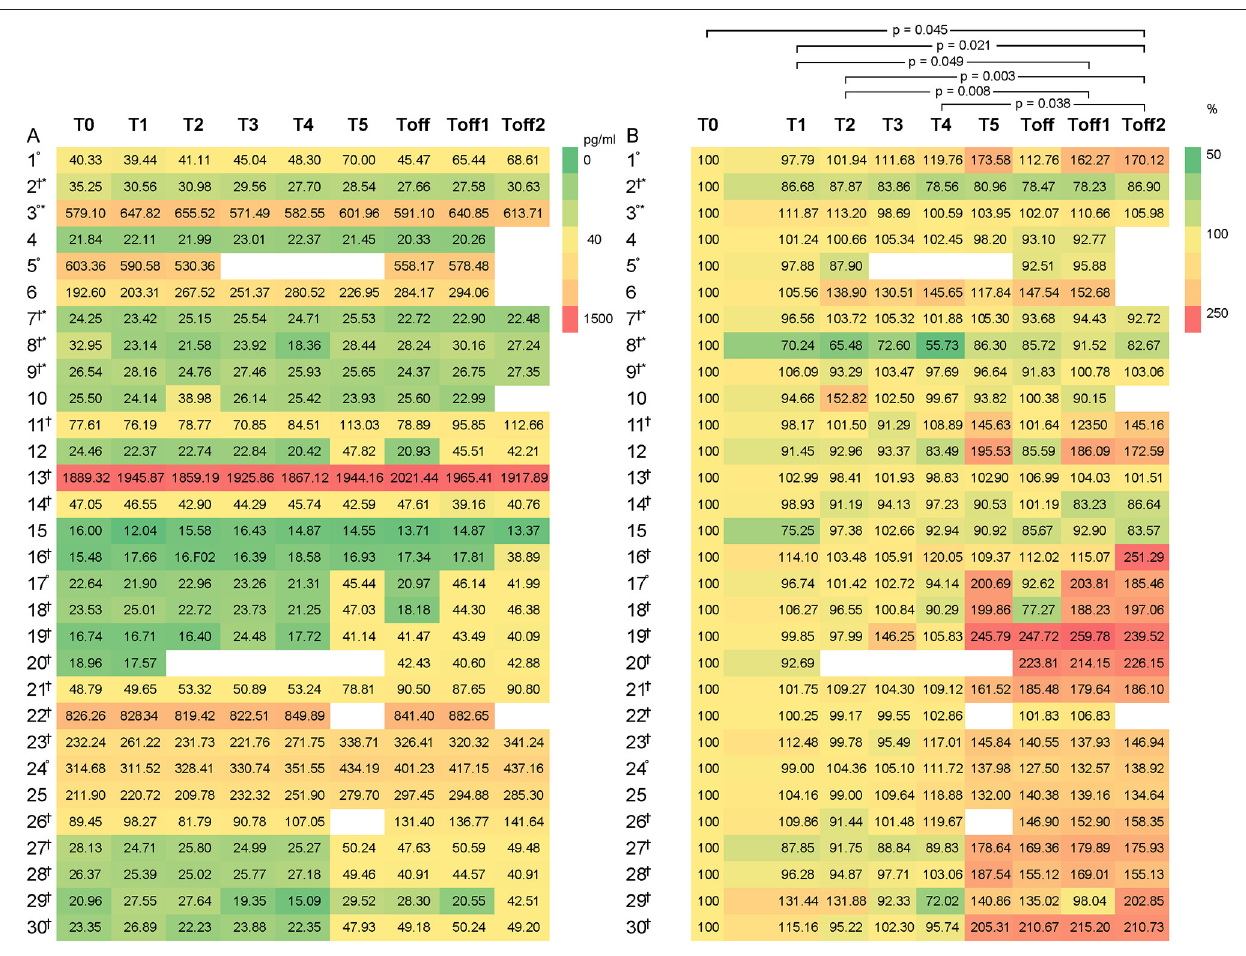
FIGURE 1 | Heat maps to illustrate the distribution of CGRP levels, given as pg/ml, among the participants (1–30). CGRP levels are displayed as colors ranging from green to red as shown in the key. The X-axis shows the different times points of the experiment with T0 as baseline, T1 as first blood sample 1h after entering the HAC and consecutive hourly blood samples. Toff represents the first blood sample immediately after leaving the HAC. On the left side (A) , the absolute values of the CGRP-levels are indicated and on the right side (B) the percentage change compared to baseline. Subject experiencing ◦ headache; † migraine; * aura during the experiment. Participant 3 experienced headache that did not fulfill the ICHD criteria for migraine headache due to a lack of nausea or photophobia and phonophobia but had aura symptoms.